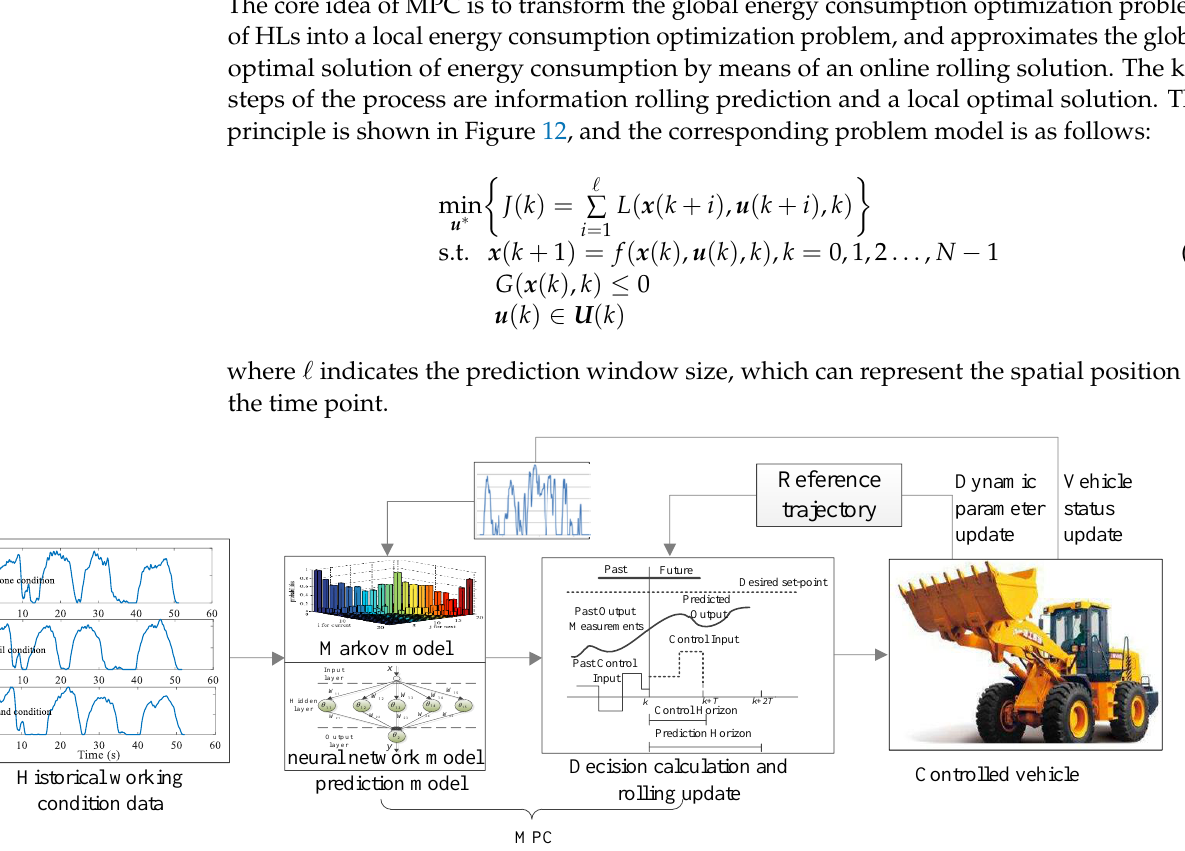
Figure 12. The design principle of an MPC EMS.